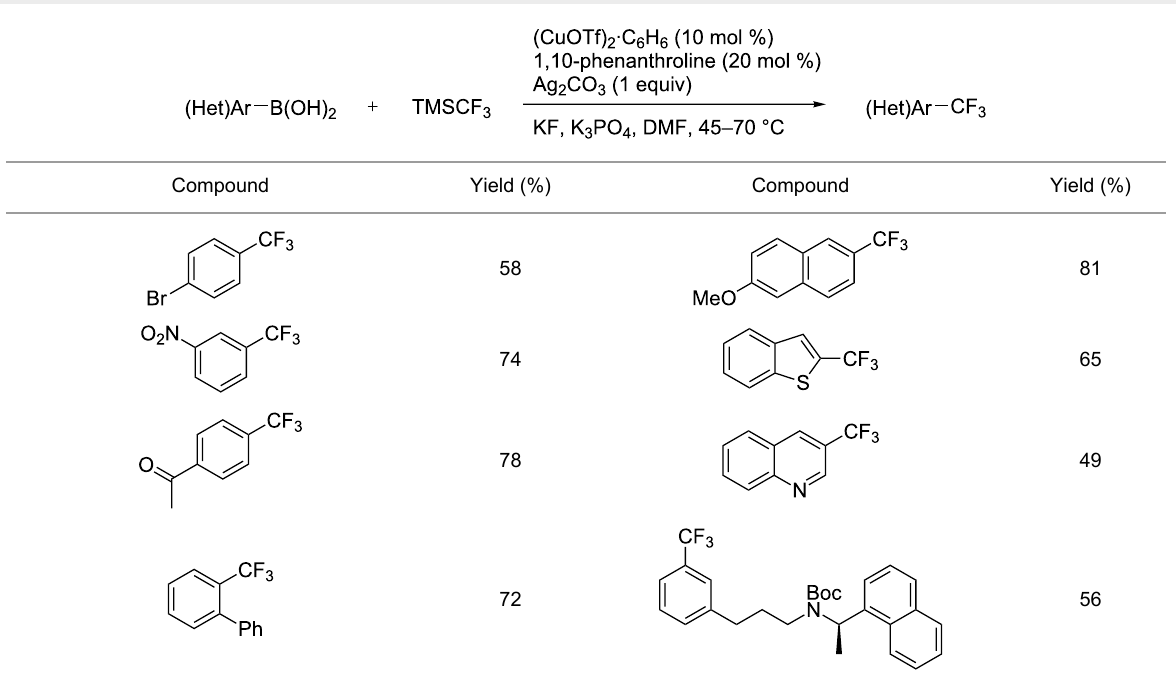
Table 22: Cu-catalyzed cross-coupling of (hetero)aryl- and alkenylboronic acids with TMSCF 3 under oxidative conditions [92].